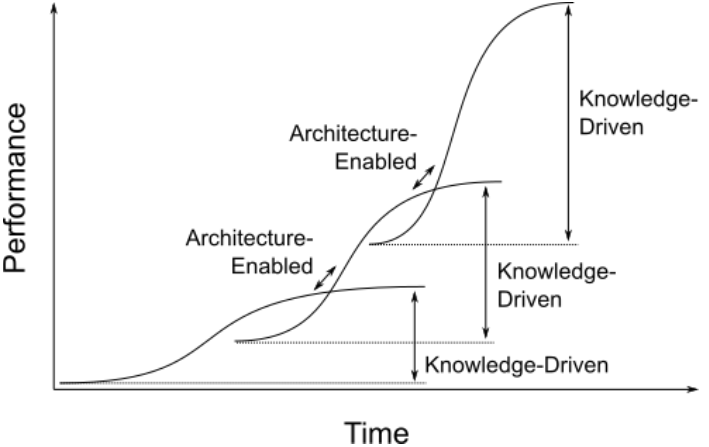
Figure 4. Notional representation of linked technology S-curves highlighting performance gains from knowledge-driven and architecture-enabling